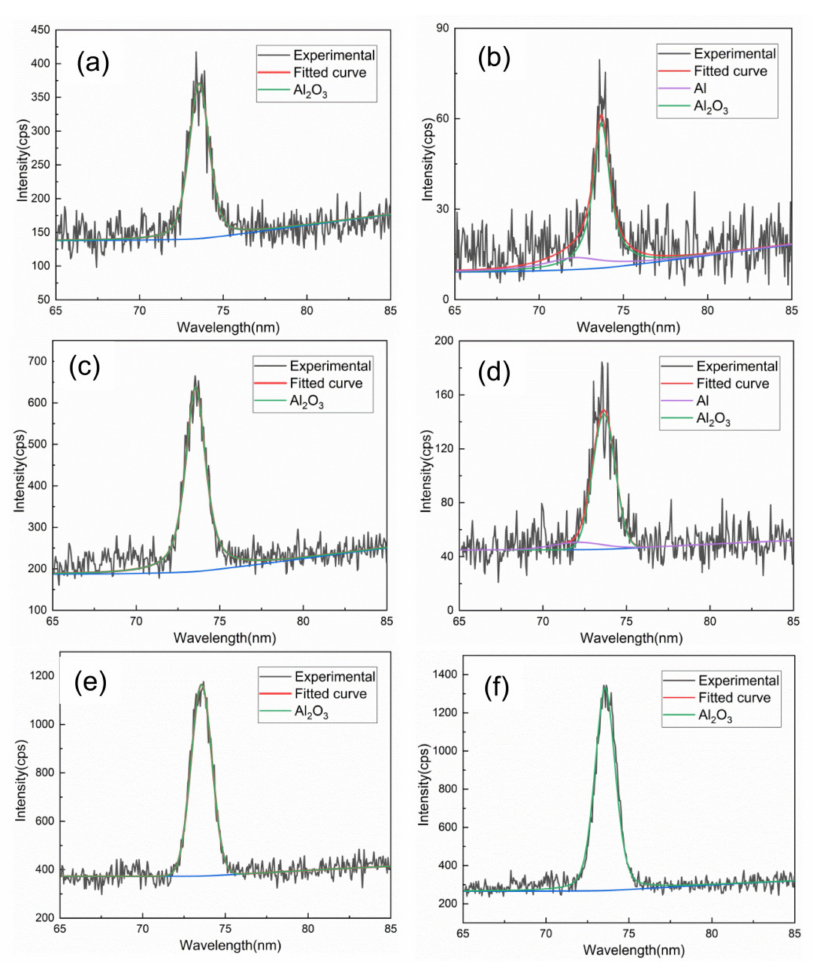
Figure 10. XPS spectrum of Al 2s at different heating times: ( a ), ( c ) and ( e ) mechanical grinding at 0.5, 2 and 10 h, ( b ), ( d ) and ( f ) laser cleaning at 0.5, 2 and 10